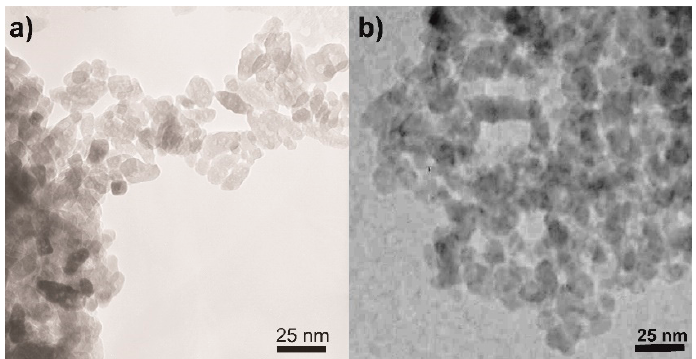
Figure 3. Selected TEM micrographs as obtained with the ( a ) undoped TiO 2 and ( b ) the Fe(2.5)-TiO 2 sample.